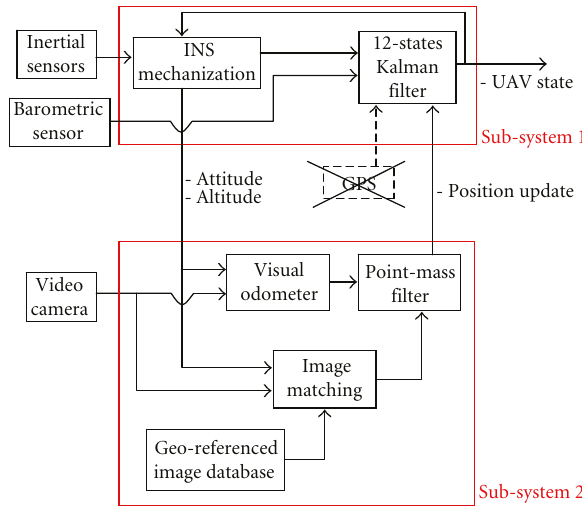
Figure 2: Sensor fusion